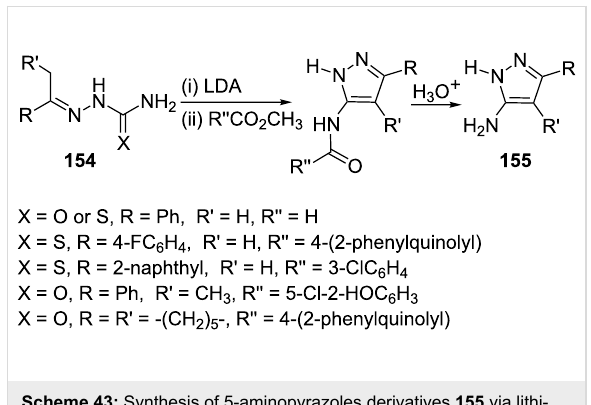
Scheme 43: Synthesis of 5-aminopyrazoles derivatives 155 via lithi- ated